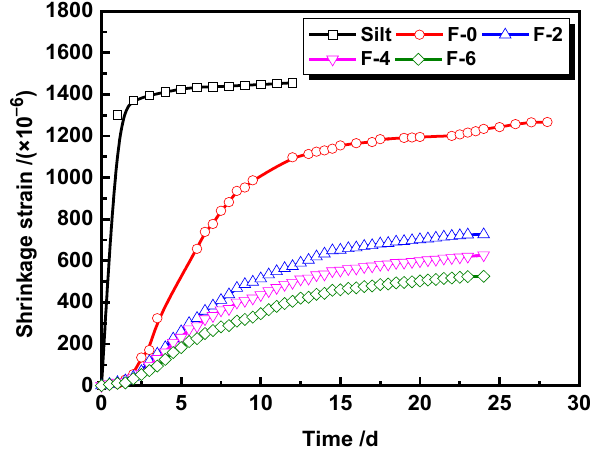
Figure 7. Variation of shrinkage strain with time.